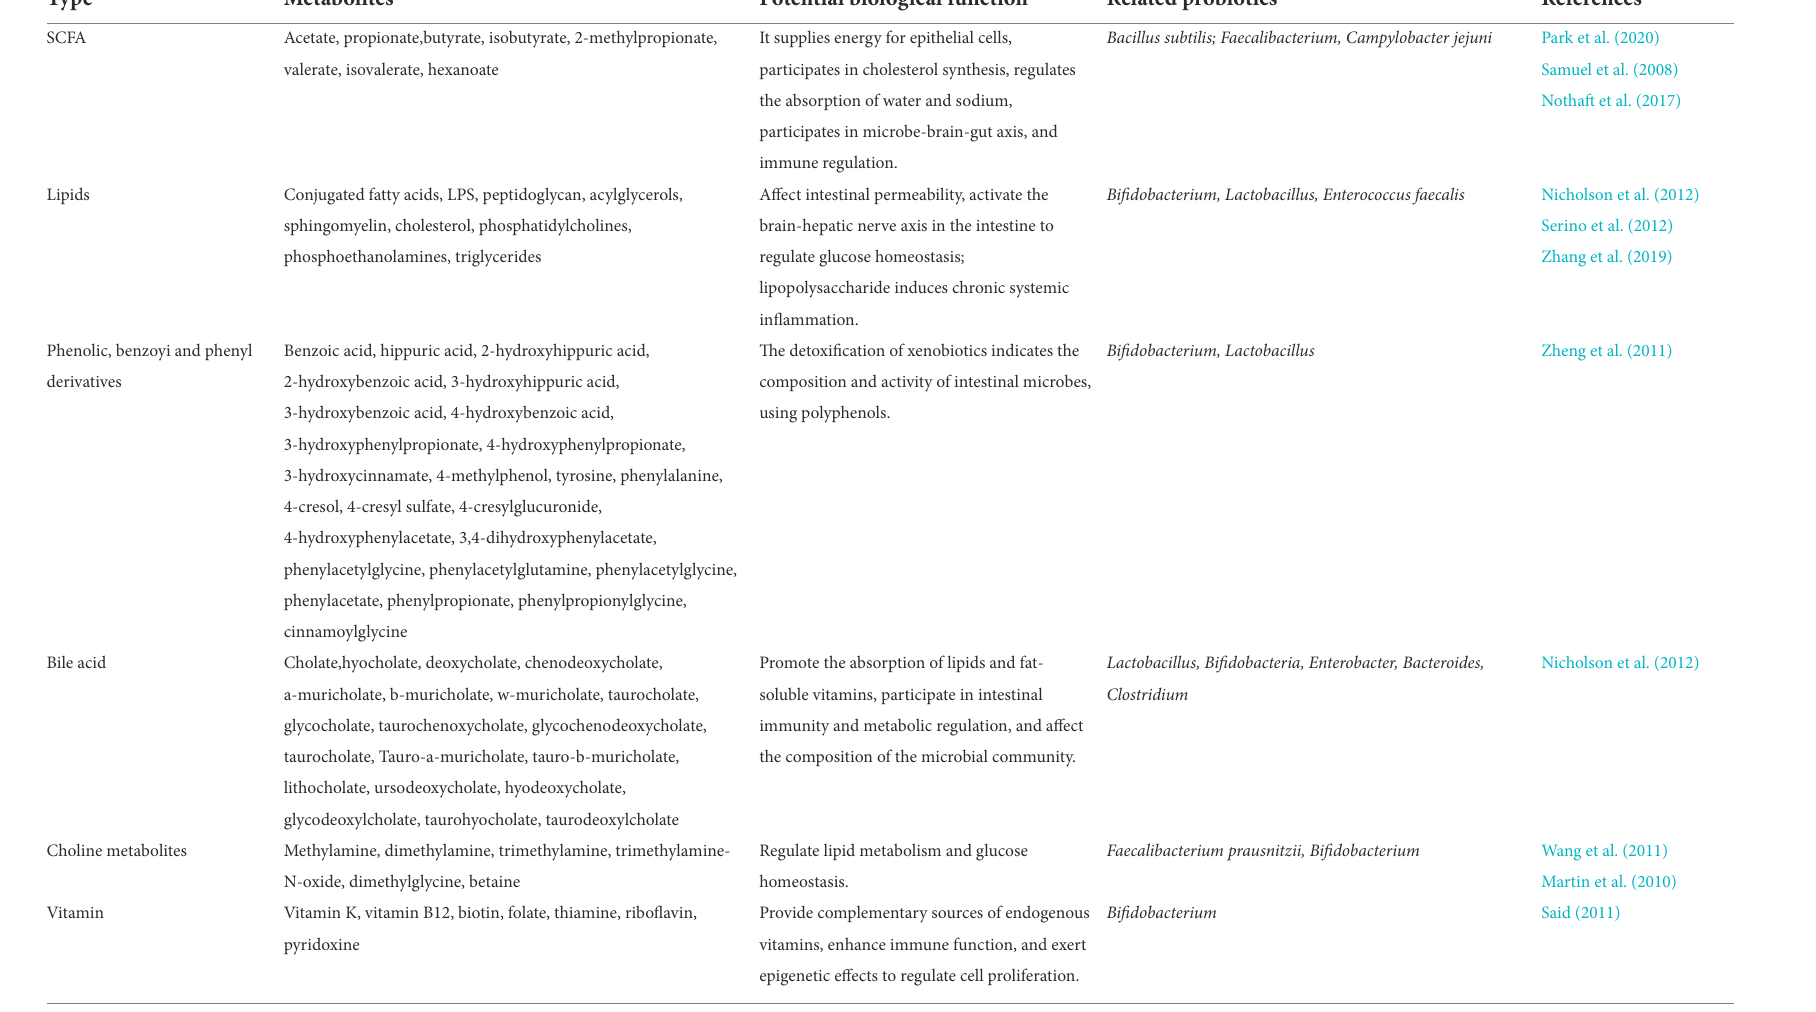
TABLE 4 Metabolites produced by